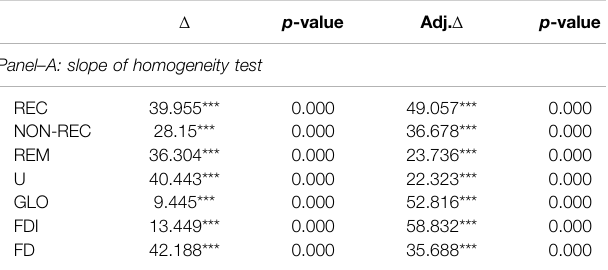
TABLE 2 | Slope of homogeneity and cross-sectional dependency